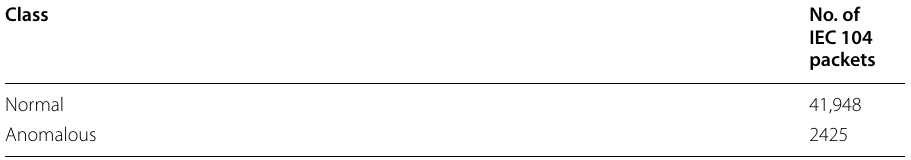
Table 2 Dataset class